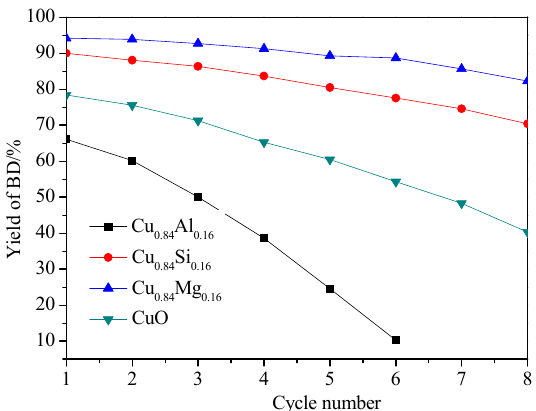
Figure 12. The yield of BD by CuO and Cu 0.84 M 0.16 catalysts as a function of the cycle number. Reaction conditions: Catalyst amount, 2.5 g; formaldehyde solution concentration, 35 vol.%; consumption of the formaldehyde solution, 50 mL; reaction temperature, 90 ◦ C, reaction time, 24 h.